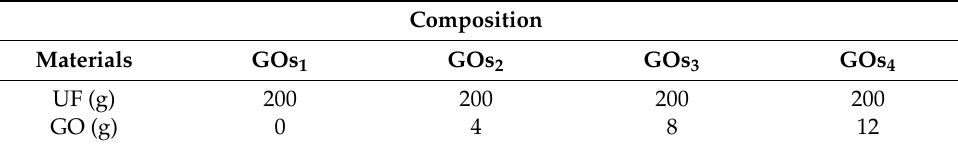
Table 2. Composition of UF–GO nanofillers.